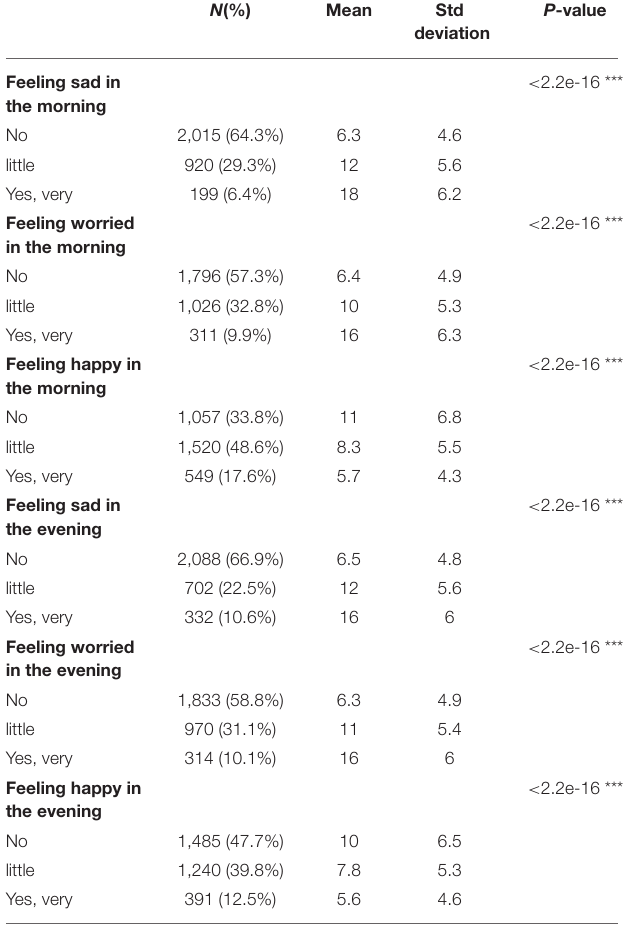
TABLE 3 | Means of scale’s scores for each mode of emotion variables.